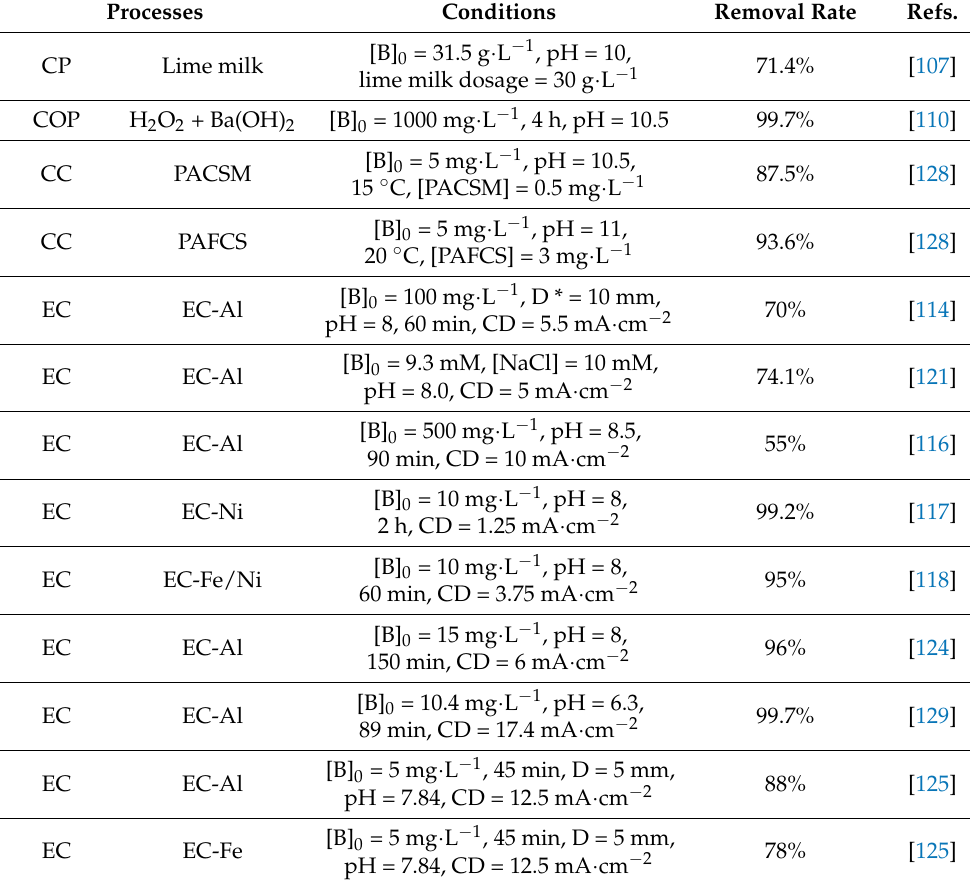
Table 16. Boron removal performances of chemical precipitation and